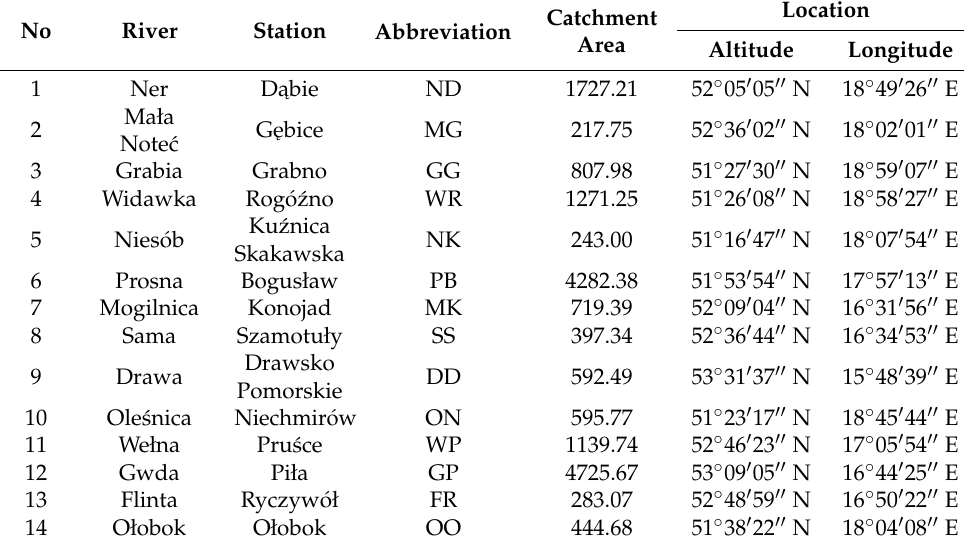
Table 1. Hydrological description.